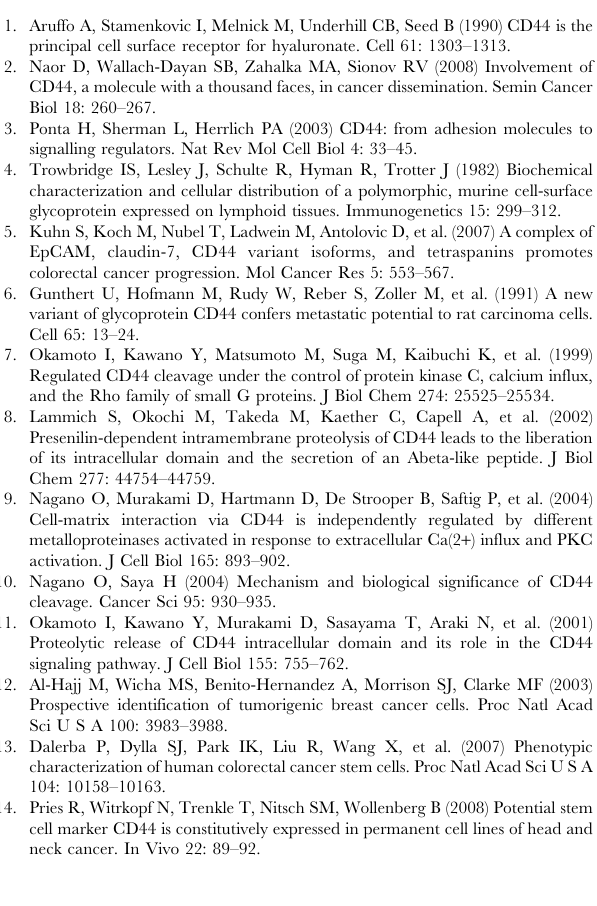
Figure S1 Hematoxylin/eosin staining was performed on kryosec- tion of normal epithelium, carcinoma in situ, grades 2 and 3 carcinomas. Stained samples were examined by two pathologists and different areas within specimens were denoted. Shown are representative examples of the entire cohort used in the present study. Figure S2 Negative controls for immunohistochemistry. Normal mucosa and grade 2 carcinoma were stained with murine pre- immune serum in combination with standardised detection systems. Nuclei were counter-stained with hematoxylin. Shown are representative results from the cohort analysed in the present